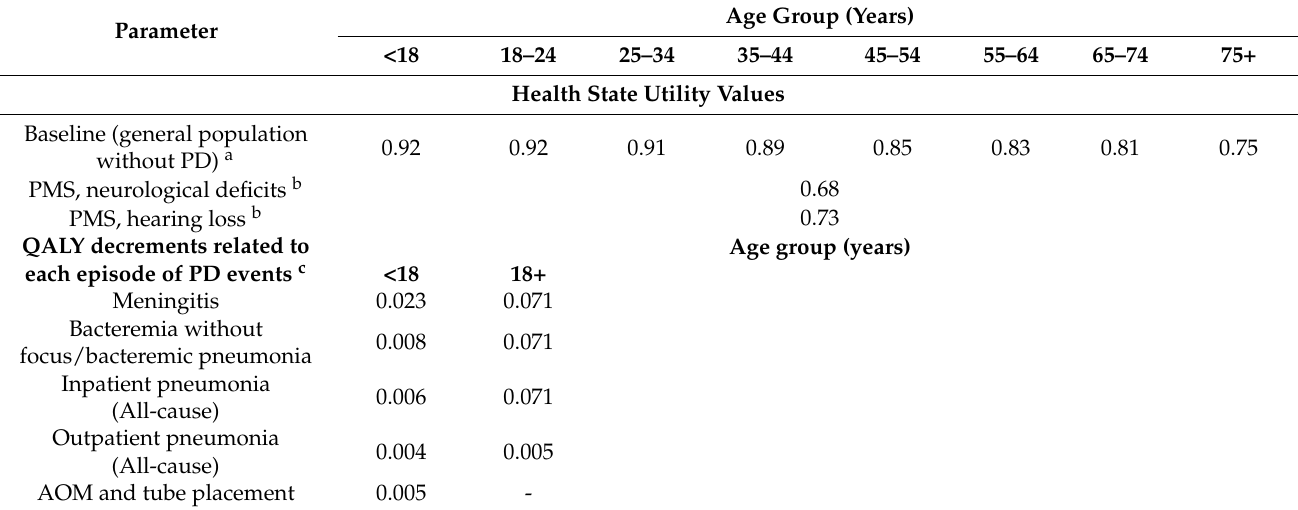
Table 3. Health state utility values and QALY decrements of PD